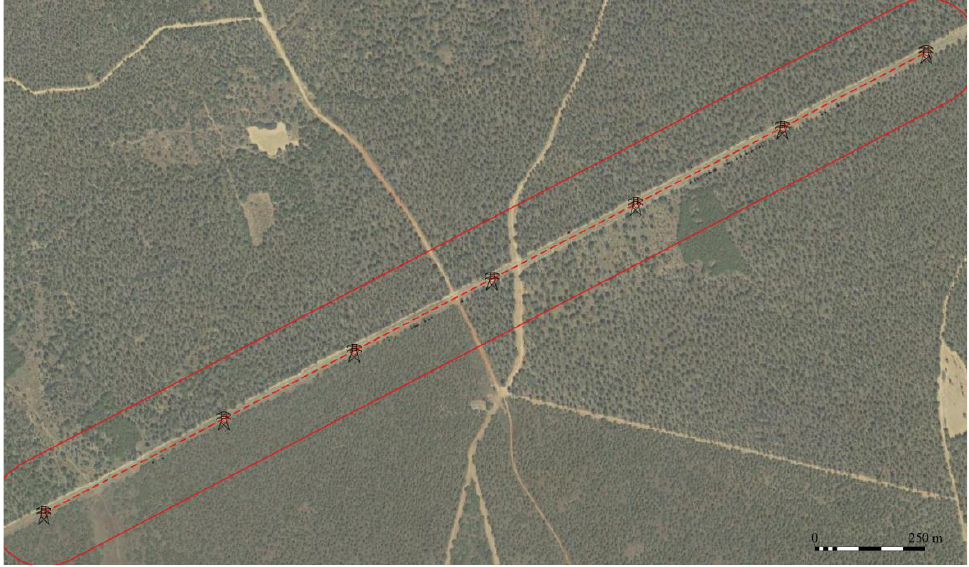
Figure 10. Risk areas obtained with drone LiDAR data from the estimation of wire groups using the point cloud.